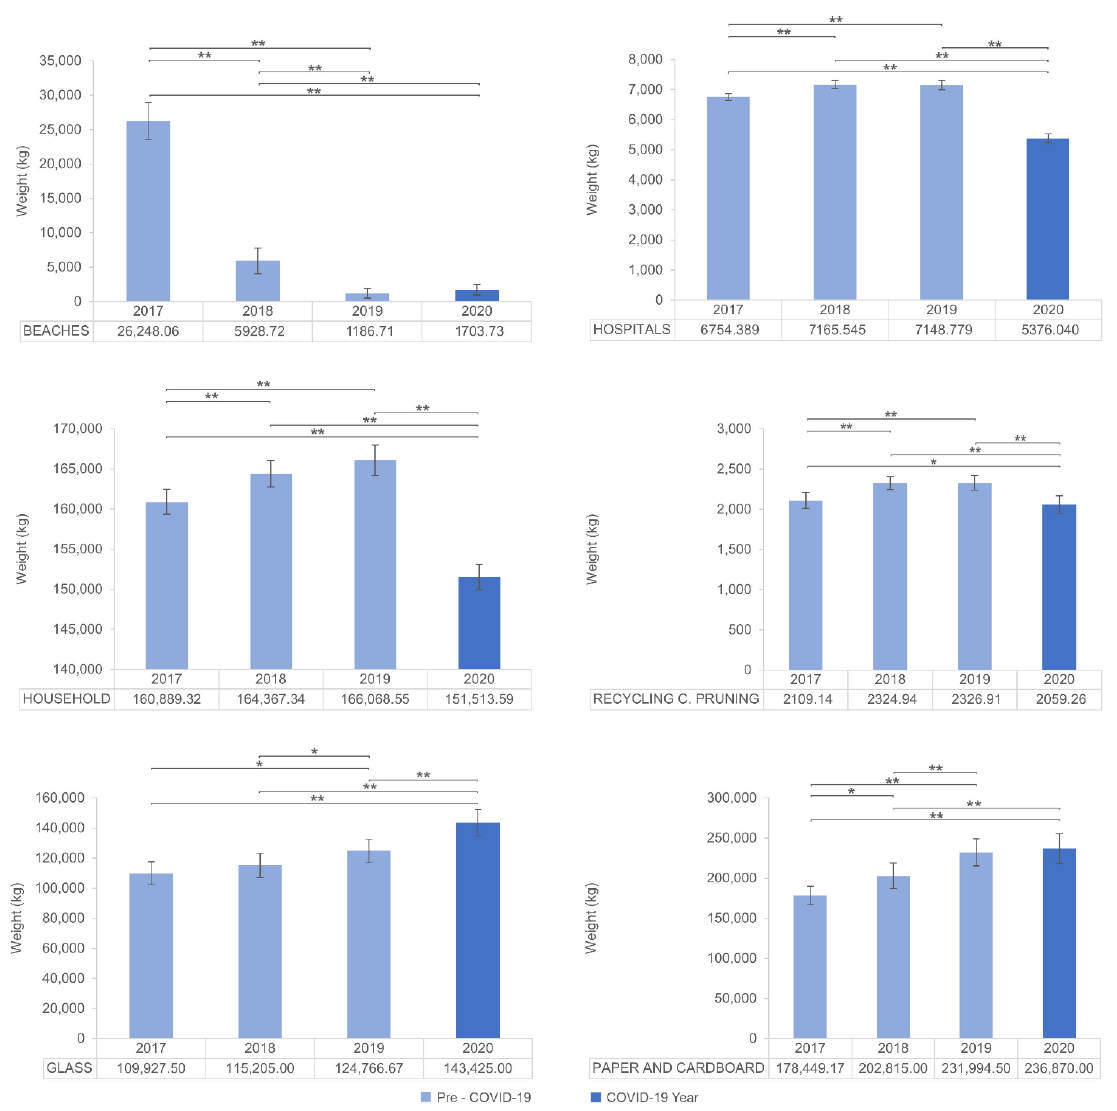
Figure 3. Mean and 95% CI for each year in waste fractions of Group 2: glass, household, hospitals, recycling centre pruning, paper and cardboard and beaches waste collection. (*) is used for p < 0.05 and (**) for p < 0.01.